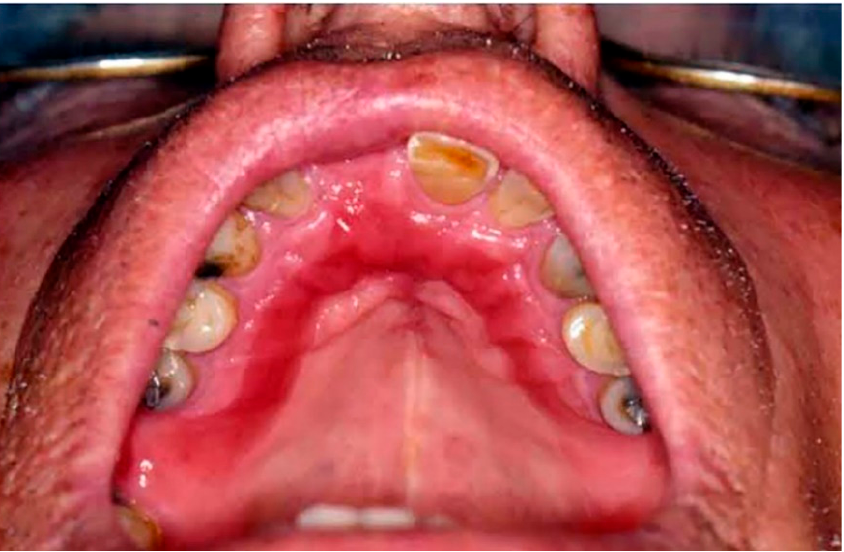
Figure 2. Diffuse involvement of the denture-bearing mucosa in a patient with an upper partial